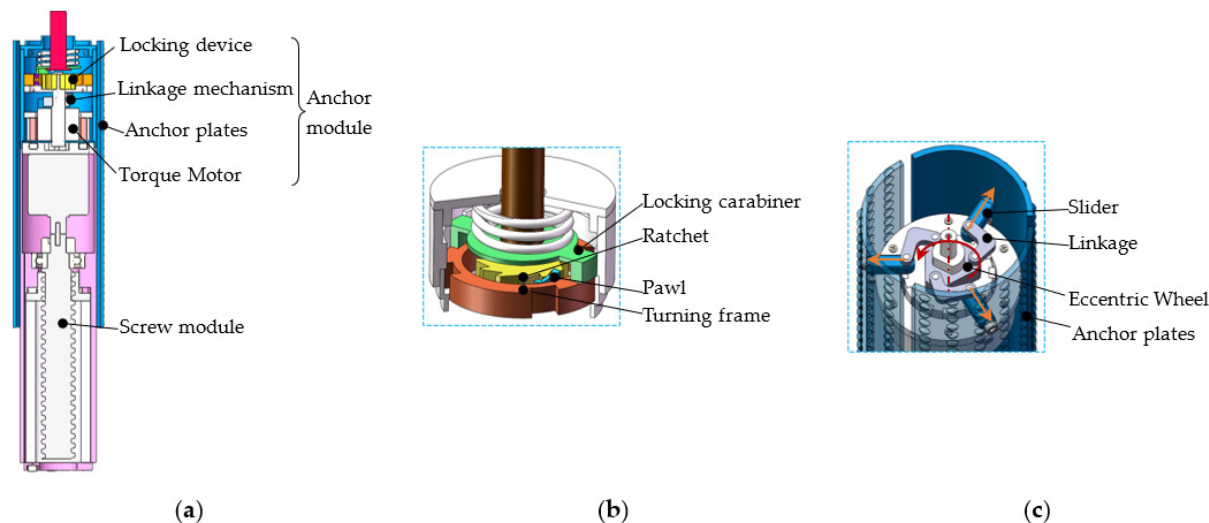
Figure 4. Design of the pressure supply part ( a ) Modules configuration ( b ) The locking device of the anchor module ( c ) Operation mechanism of the anchor module.